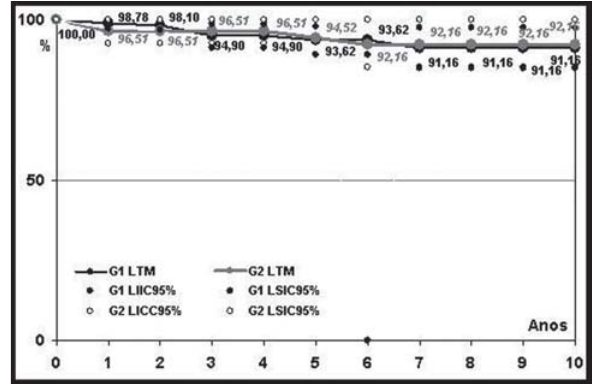
Fig. 4 - Curvas atuariais e pontos de limites superior e inferior do intervalo de confiança de 95%, de acordo com os conjuntos de grupos (G1 e G2):Livres de eventos tromboembólicos maiores – LTM. Limite inferior do intervalo de confiança 95% - LIIC 95%; Limite superior do intervalo de confiança 95% - LSIC 95%. Os números próximos aos pontos de inflexão das curvas são referentes